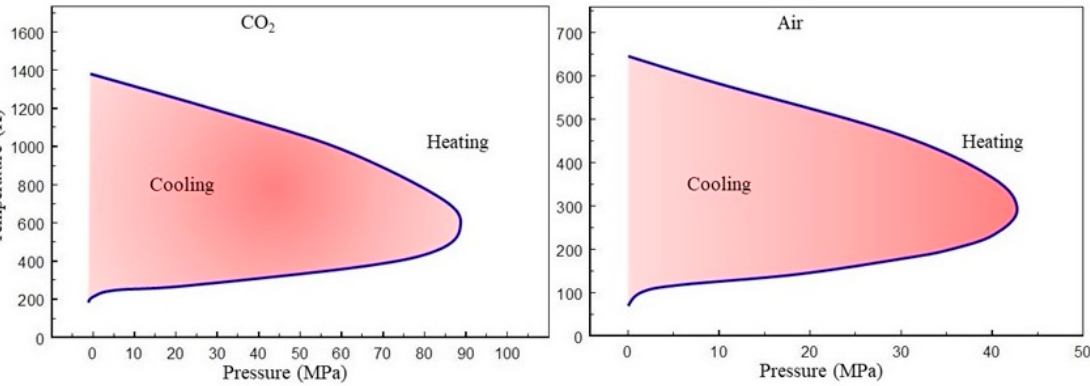
Figure 3. The Joule–Thomson temperature inversion curve for CO 2 and air. The cooling region for air covers a range of temperature from about 100 K to 650 K and a pressure range up to 42.5 MPa. The cooling region associated with CO 2 has a much bigger range in both pressure and temperature. Let us assume that both gaseous CO 2 and air are stored in a container with pressures ranging from 1 to 5 MPa and are in thermal equilibrium with the surroundings so that the temperature of the stored gas can be somewhere from 35 ◦ C (308 K) to 40 ◦ C (313 K). These conditions fall into the cooling regions of both CO 2 and air as shown in Figure 3. Thus, as these gases expand, the temperature of the expanded streams entering a cooling device will be lower than their temperatures in the storage container. However, the values of µ JT of CO 2 are 4.9 to 5.6 times higher than those of air as shown in Figure 4, and the temperature of the CO 2 entering a cooling device, as given by Equation (2), depends on the storage tank temperature and the pressure, and it is 7 to 40 K lower than that of air. The data are based on the correlations reported by Span and Wagner [20] for CO 2 and the correlations reported by Kadoya et al. [24] and by Lemmon et al. [25,26] for